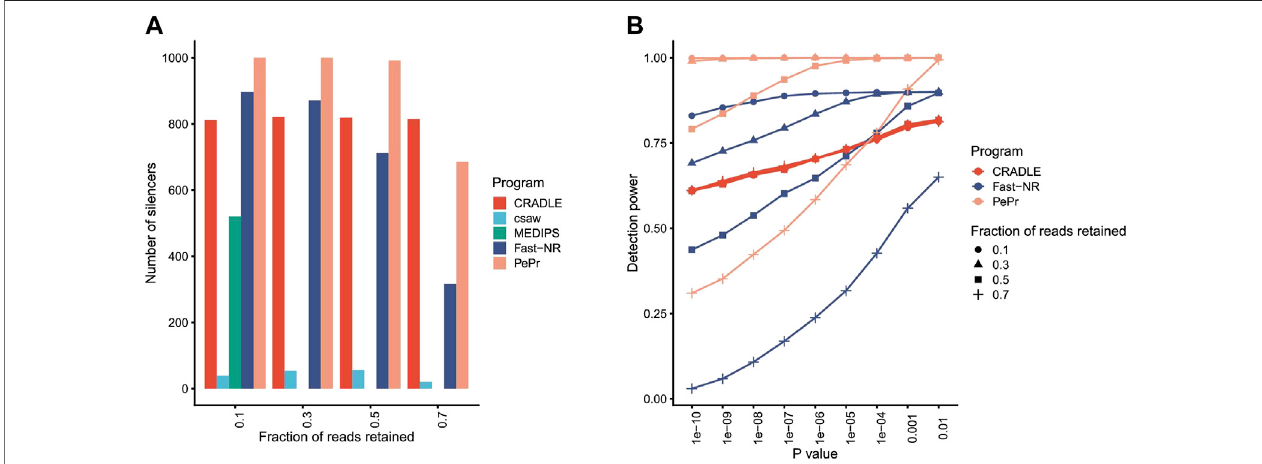
FIGURE2| Programperformancecomparisononsimulateddatasets. (A) Thenumberofsilencersidenti fi edbydifferentprograms.Thefractionofreadsretainedto simulate silencers is shown under x axis. p value < 10 − 5 . (B) The silencer detection power of different programs at different levels of con fi dence. Detection power is the ratio between number of identi fi ed silencers over total number of simulated